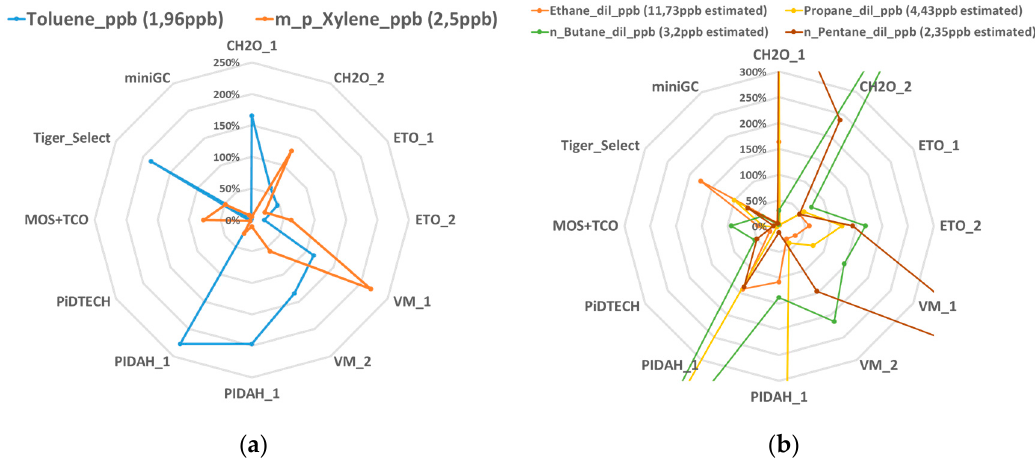
Figure 1. Estimation of the sensor sensitivity to organics interfering